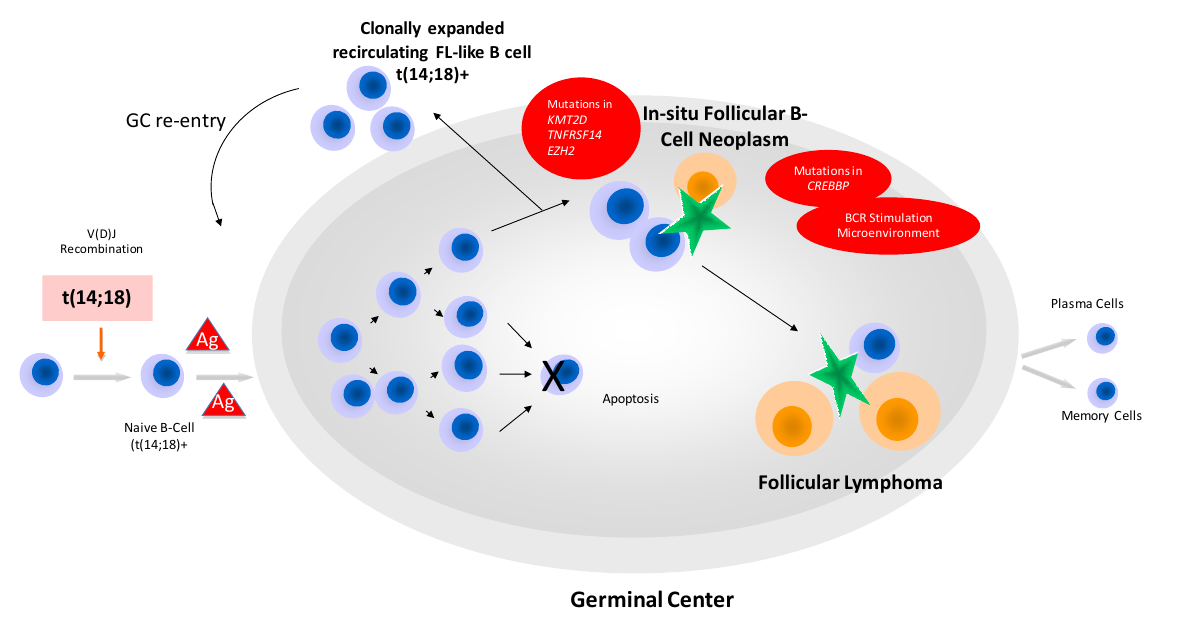
Figure 3. A schematic overview on the evolution of follicular lymphoma. The t(14;18) arose in pre-B- cells during failures in VDJ joining and leads to the generation of long-lived FL-like B-cells. Via several re-entries into germinal centers, these t(14;18)-positive B-cells acquire additional mutations enabling them to be founders of ISFN or manifest lymphoma. Orange cells and green stars represent T-cells and follicular dendritic cells, respectively. Under physiological conditions germinal center B-cells undergo apoptosis, while this process is inhibited in FL (marked by